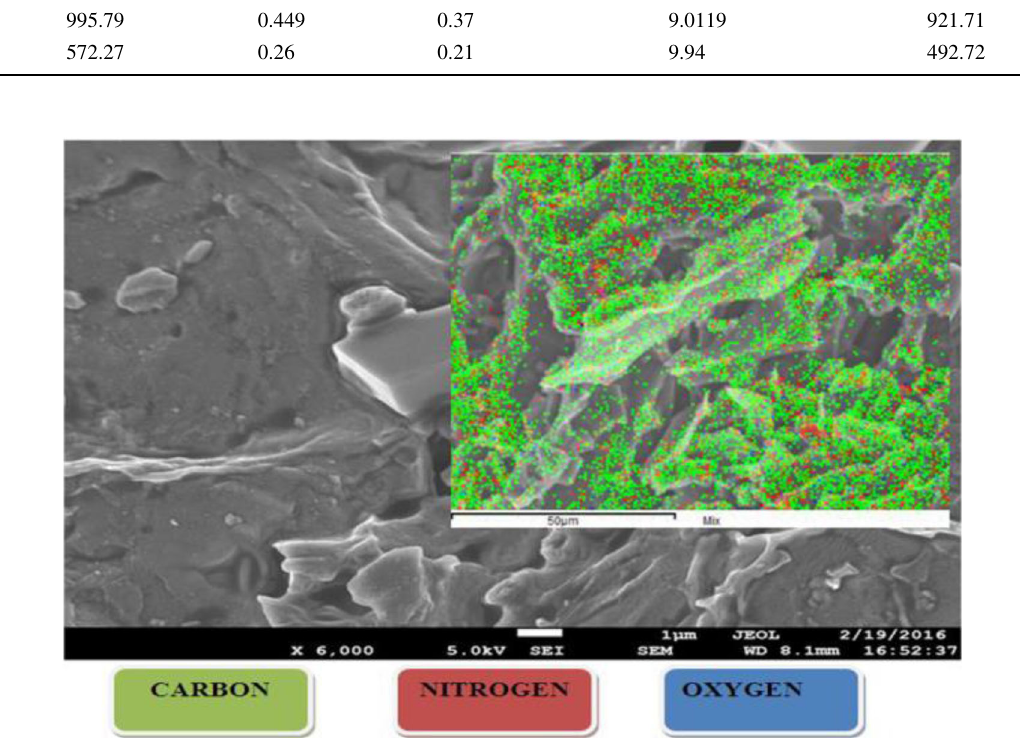
Fig. 12 SEM Analysis of MEA-AC (at optimum condition)